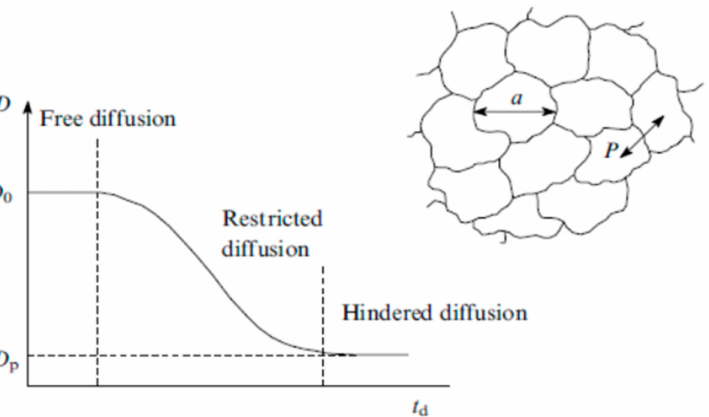
Figure A2. Illustration of the dependence of the apparent diffusion coefficient D on diffusion time t d for the case of restricted diffusion. D 0 is the free diffusion coefficient, D p is the restricted diffusion coefficient, a is the size of restriction region (pore or cell diameter), a = (6Dt d ) 1/2 ; P is the permeability of pore (cell)